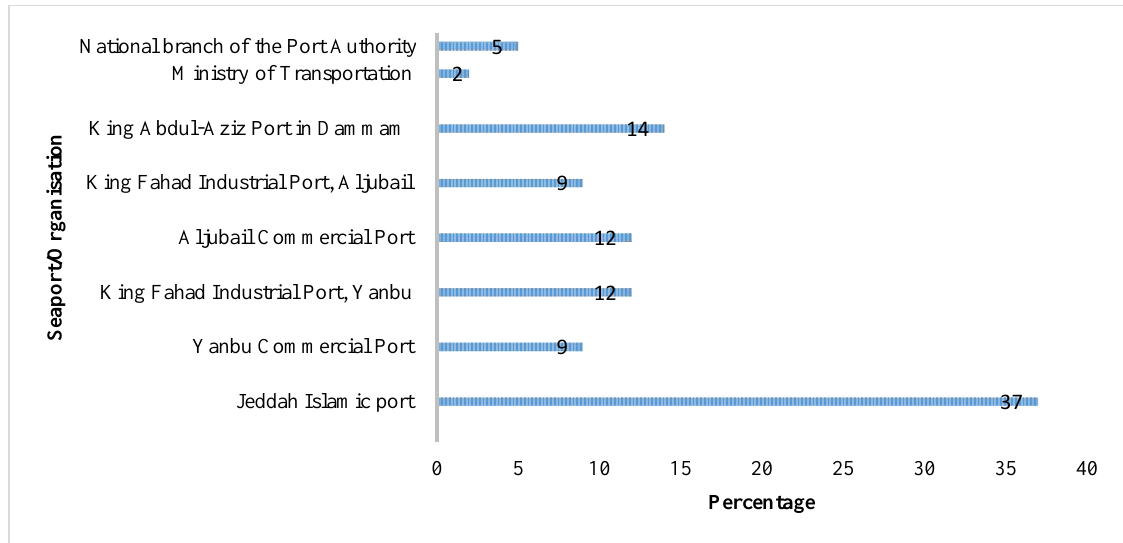
Figure 2: Participants’